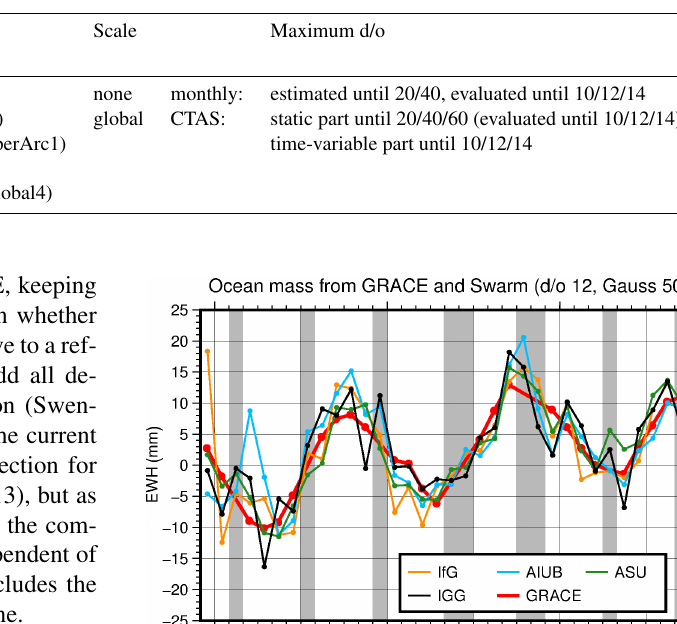
Table 4. Parameterizations that have been tested in this study. This table should not be read row-wise. It lists all possible choices for each heading. One solution can consist of any combination of the entries, for example, a monthly solution with an arc length of 60min, modeled non-gravitational accelerations, a constant global bias, no scaling factor, max. d/o estimated until 40, and evaluated until d/o 10.